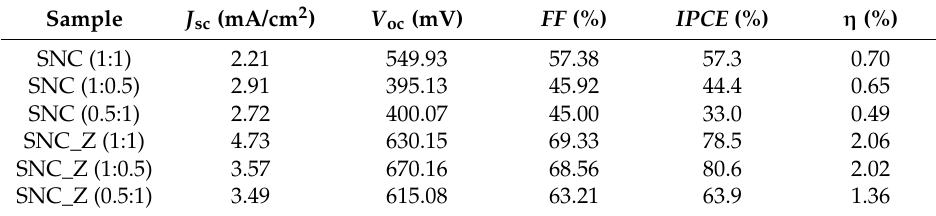
Table 1. Photoelectrochemical performance of the DSSCs based on different photoanodes.